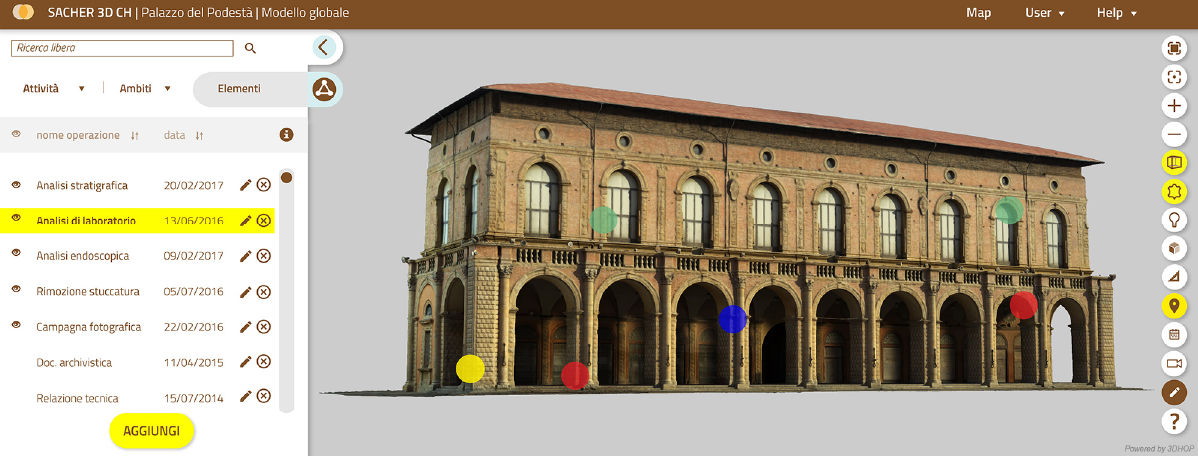
Figure 4. SACHER 3D CH interface and 3D annotation tools for the pilot case study (Palazzo del Podestà,